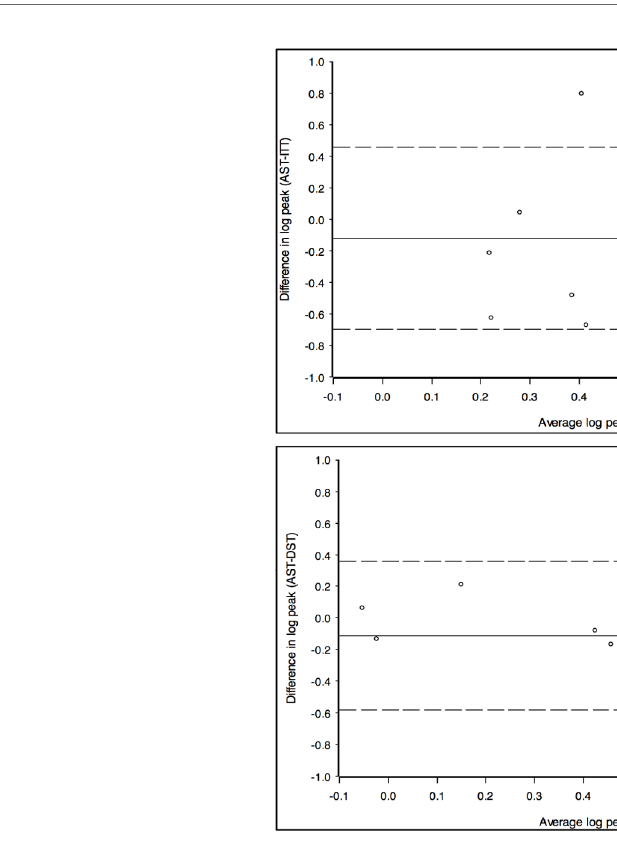
FIGURE 3 | Bland-Altman chart to assess the agreement between GH peaks recorded after AST and ITT (A) and between AST and DST (B) . Y axis: logarithm of the difference between the peaks of GH recorded in the same patient after AST and ITT (A) or between AST and DST (B) . X axis: logarithm of the mean value of GH peaks recorded in the same patient after AST and ITT (A) or after AST and DST (B) . The chart represents the mean value of the difference between the two results recorded in each patient (solid horizontal line) and it is statistically lower than 0 in both Figures. Dotted horizontal line represent -2 and +2 SD.